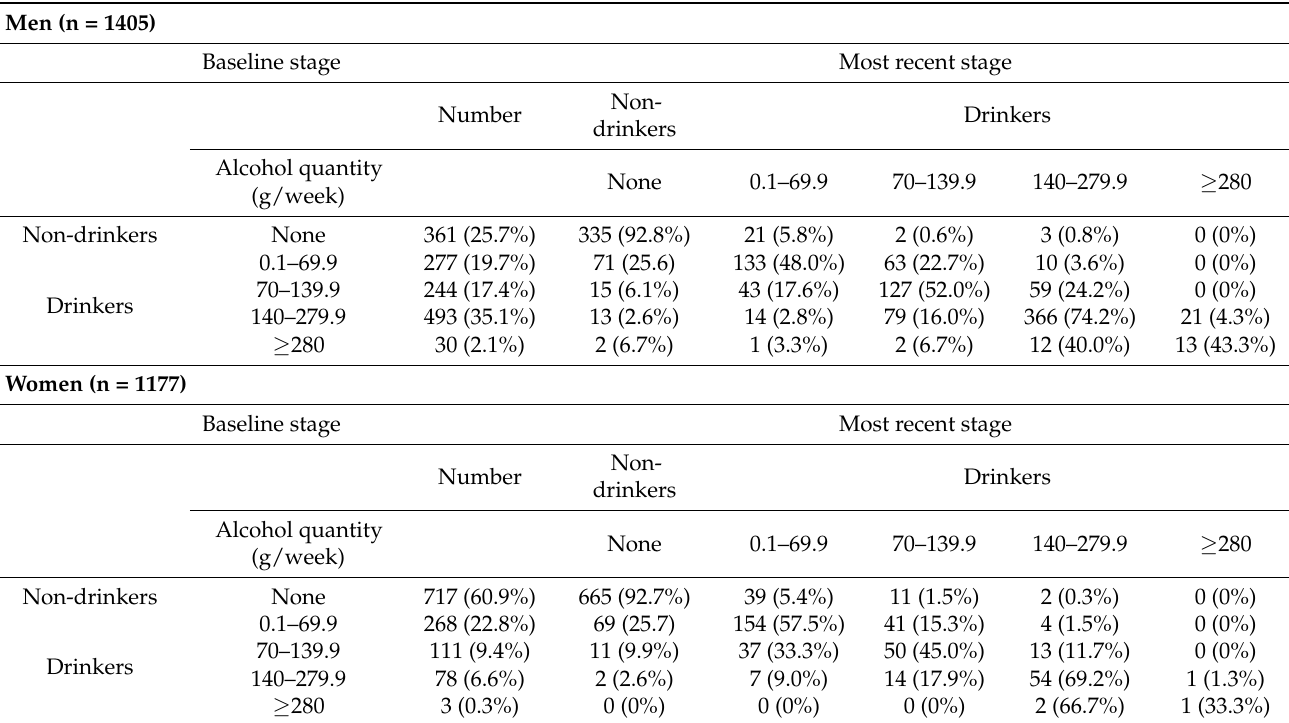
Table 2. Change in alcohol quantity between baseline and final measurements (n = 2582) according to sex.